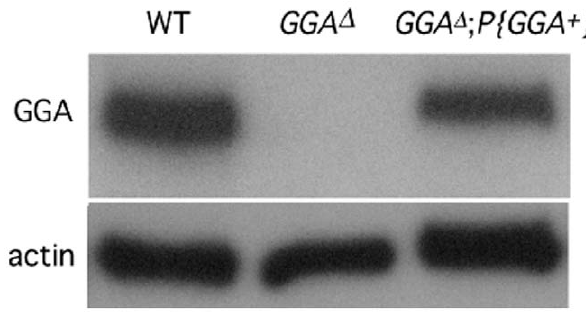
Figure 4. A GGA transgene complements the protein-null phenotype of GGA D flies. GGA D ;P{GGA + } restored the GGA protein to wild type levels. Actin levels from corresponding lane are shown below. All images were taken from the same blot at the same exposure.